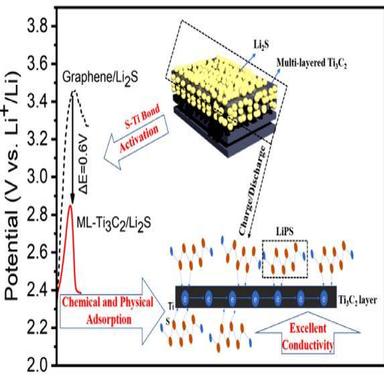
Schematic diagram of the structure and advantages of ML-Ti3C2/Li2S composites.